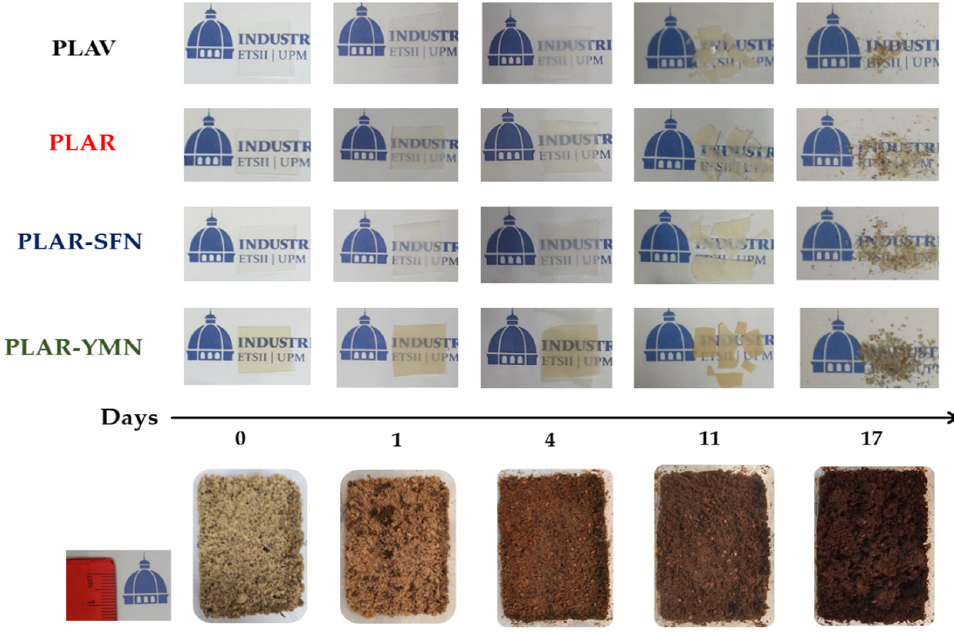
Figure 10. Visual appearance of the films and the compost medium during the composting test.